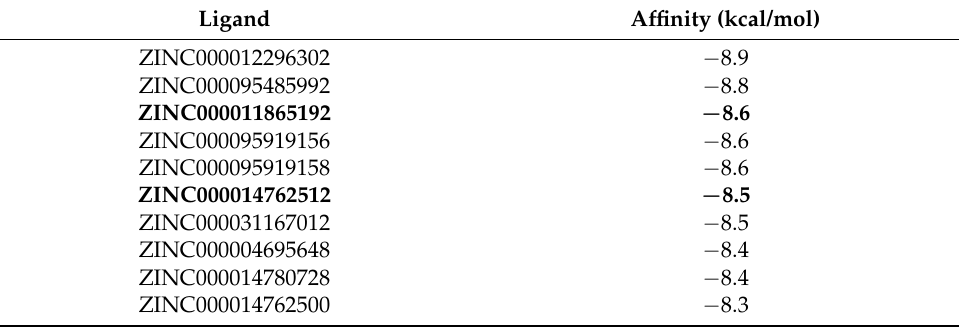
Table 2. Top 10 scoring molecules against PhcR